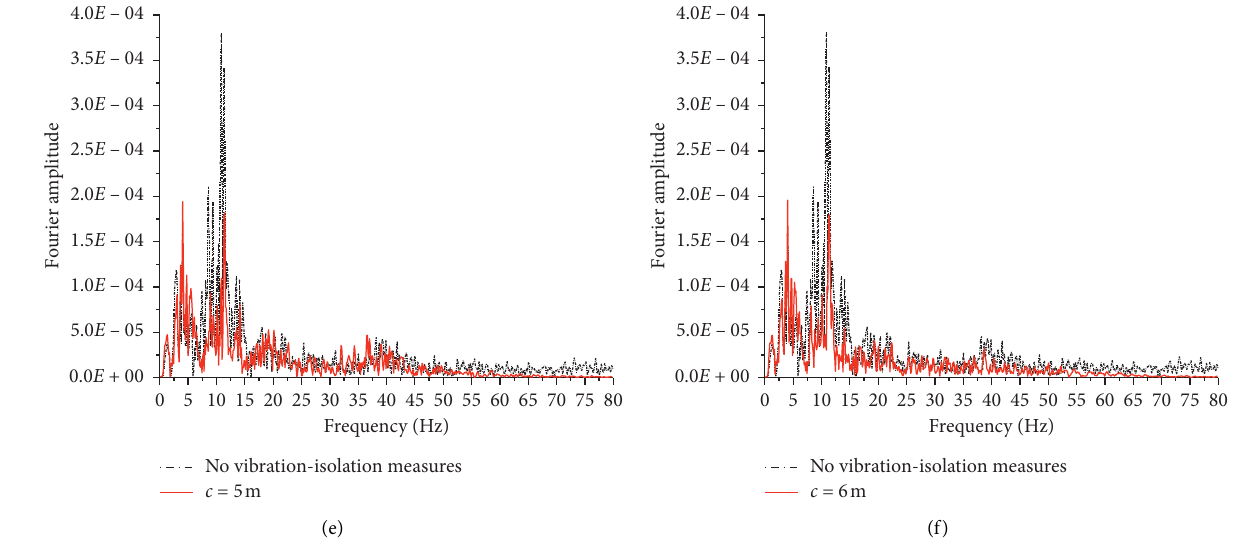
Figure 36: Influence of row spacing ( c ) on vibration-isolation effect (comparison of frequency